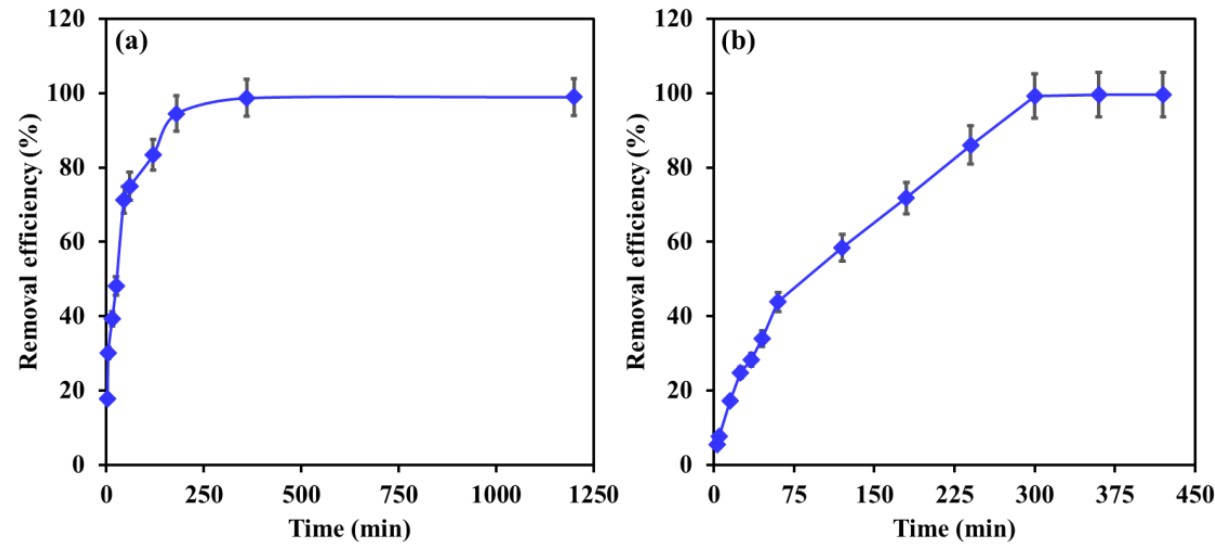
Figure 8. The influence of contact time on the removal efficiency of ( a ) EBT and ( b ) Cr by Mg − Ca − Al − LDO composite. [EBT] i = 50 mg/L; [Cr] i = 30 mg/L; temperature, 22 °C; dosage, EBT 0.75 g/L, Cr 1 g/L; [pH] I , EBT 5.2, Cr 6.